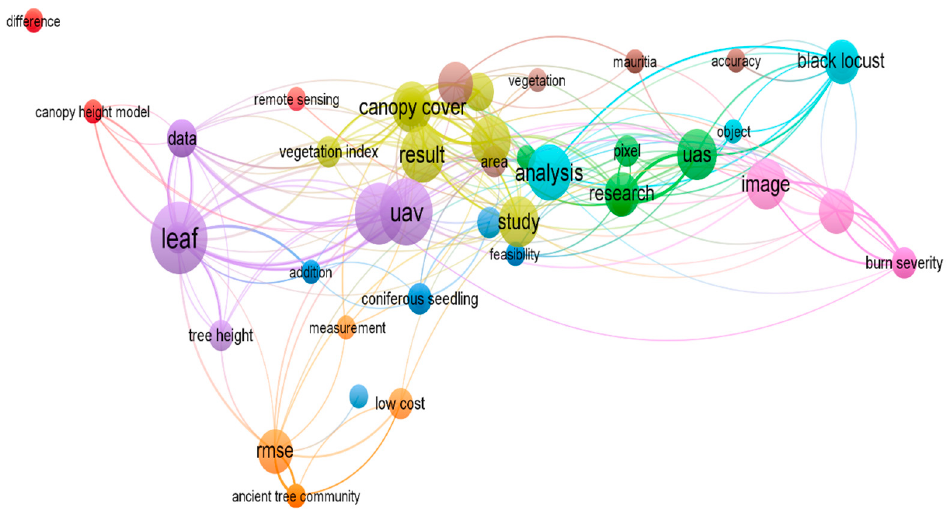
Figure 1. Term clustering map based on the SI publications. Different colors represent the terms belonging to different clusters. The size of the term is based on the number of occurrences. The connecting lines indicate the strongest co-occurrence links between terms.